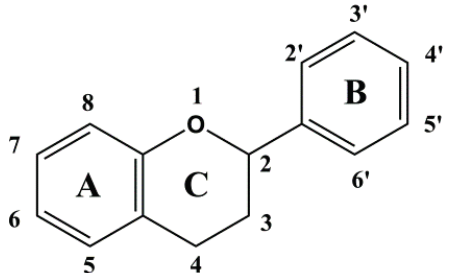
Table 2. The basic chemical structure of the main flavonoids compounds